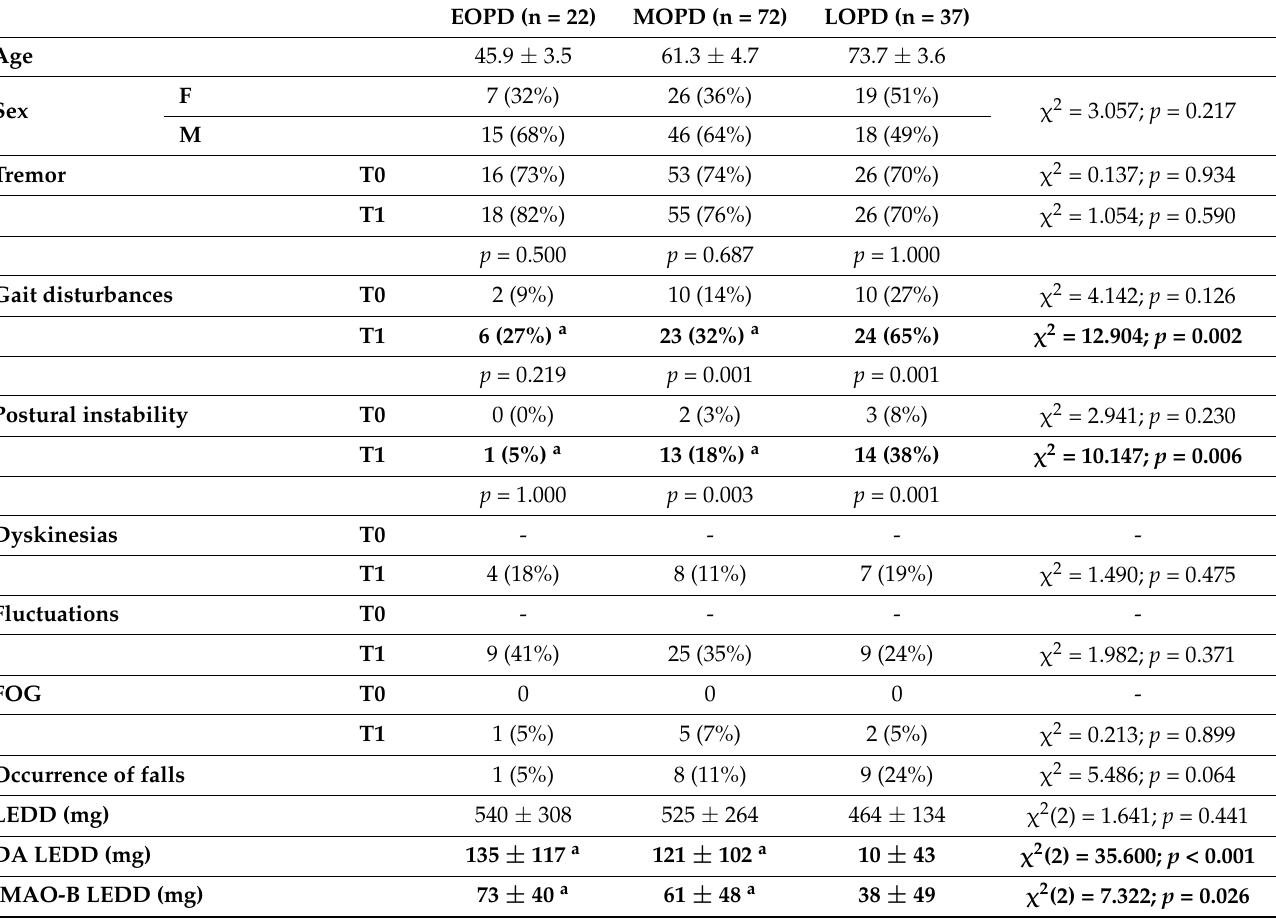
Table 1. Demographics, motor features and LEDD of the investigated population and comparisons across age groups and between T0 and T1. Comparisons across the 3 groups are displayed on the horizontal axis (chi-squared and Kruskal–Wallis tests) and comparisons between T0 and T1 are displayed on the vertical axis (McNemar’s test). Significant results at baseline are highlighted in bold. Significant pairwise post hoc comparisons are shown by superscript letters, as indicated in the legend at the bottom of the table. SD: standard deviation; EOPD: Early-Onset-PD; MOPD: Middle-Onset-PD; LOPD: Late-Onset-PD; FOG: freezing of gait; LEDD: levodopa-equivalent daily dose; DA: dopamine agonist; iMAO-B: monoamine oxidase-B inhibitors; F: females; M: males; PD: Parkinson’s